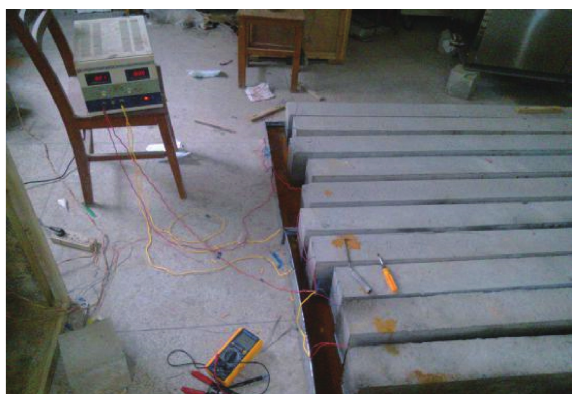
Figure 7: Accelerated corrosion photos of test